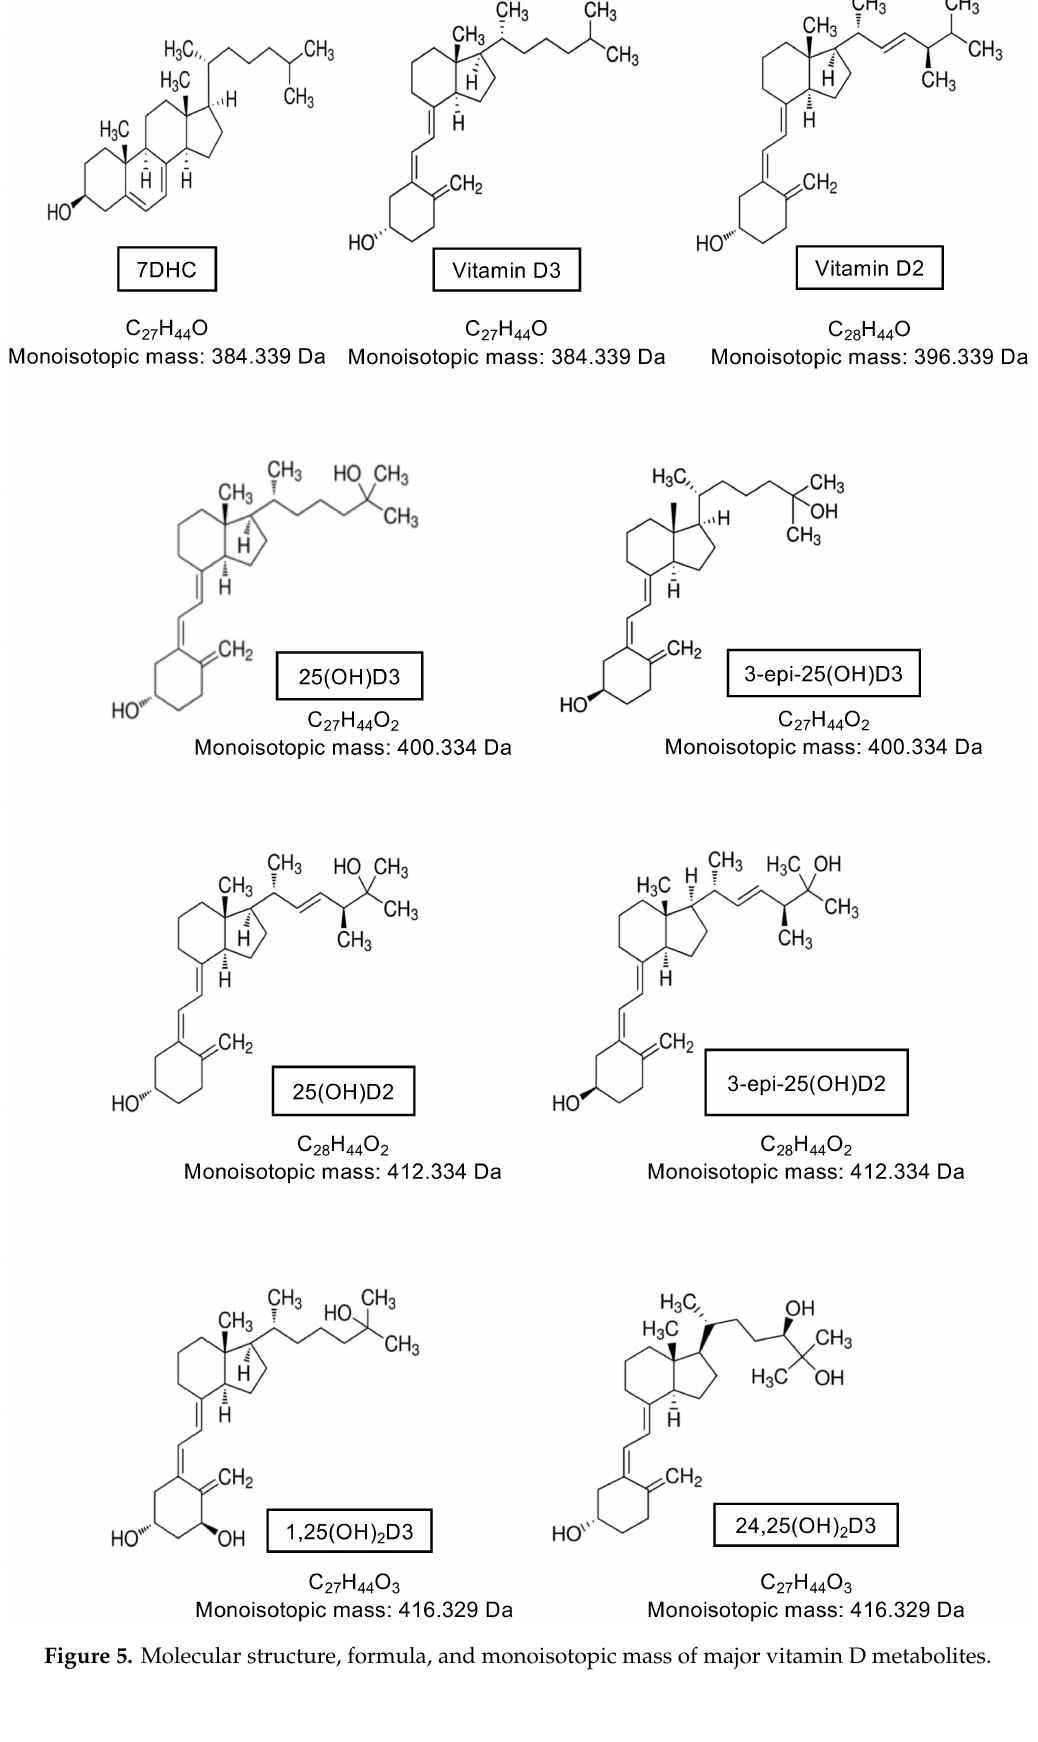
Figure 5. Molecular structure, formula, and monoisotopic mass of major vitamin D metabolites.